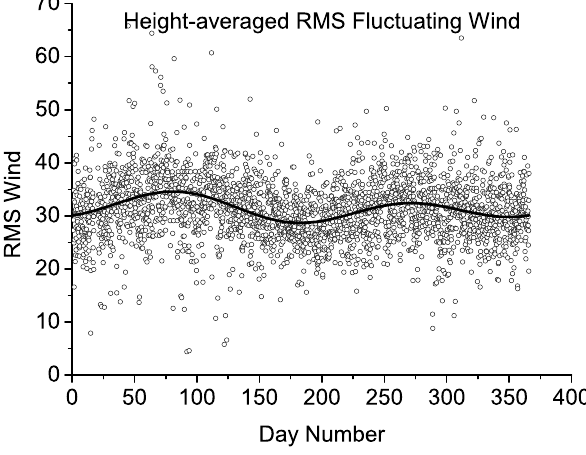
Fig. 1. Height-averaged 3-h fluctuating wind samples for the year of 2005 at Cachoeira